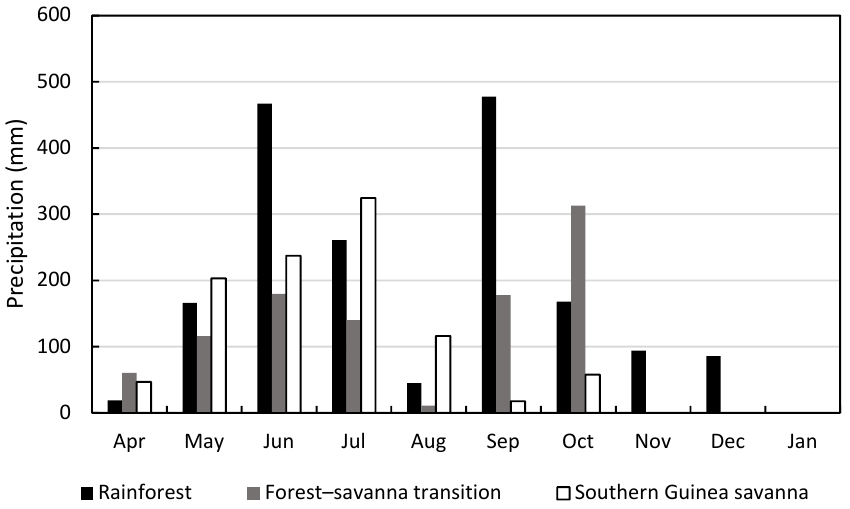
Figure 1. Rainfall (mm per month) over three different locations in Nigeria from April 2017 to January 2018.